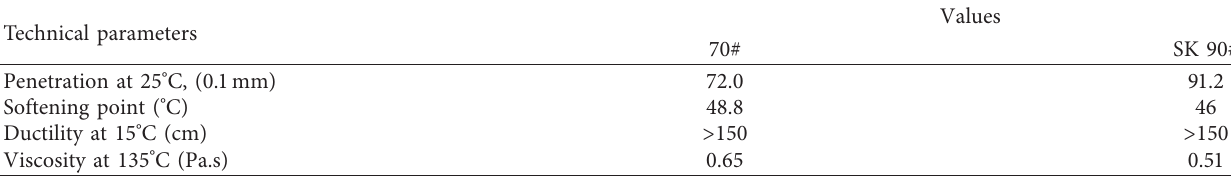
Table 1: Properties of the 70# and 90# matrix asphalt